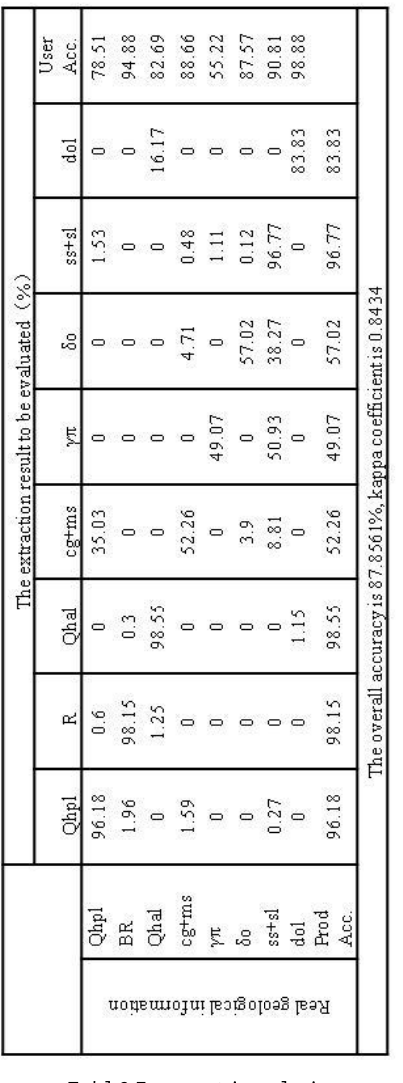
Table2 Error matrix analysis